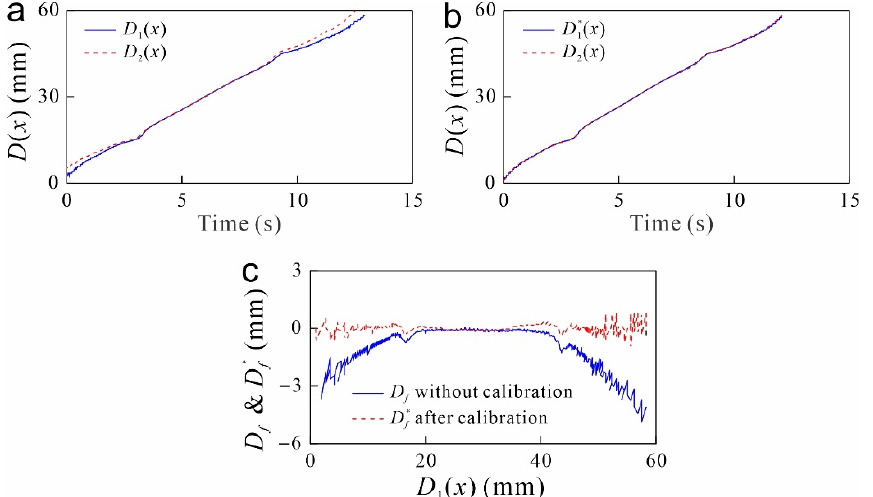
Figure 5. Calibration results of the nut displacement and initial spring deformation measurement error. ( a ) The comparisons between the uncalibrated nut displacement D 1 and output block dis- placement D 2 ; ( b ) the comparisons between the calibrated nut displacement D ∗ and output block displacement D 2 ; ( c ) the comparison of the initial spring deformation measurement error D f and the residual spring deformation measurement error D ∗ after calibration.